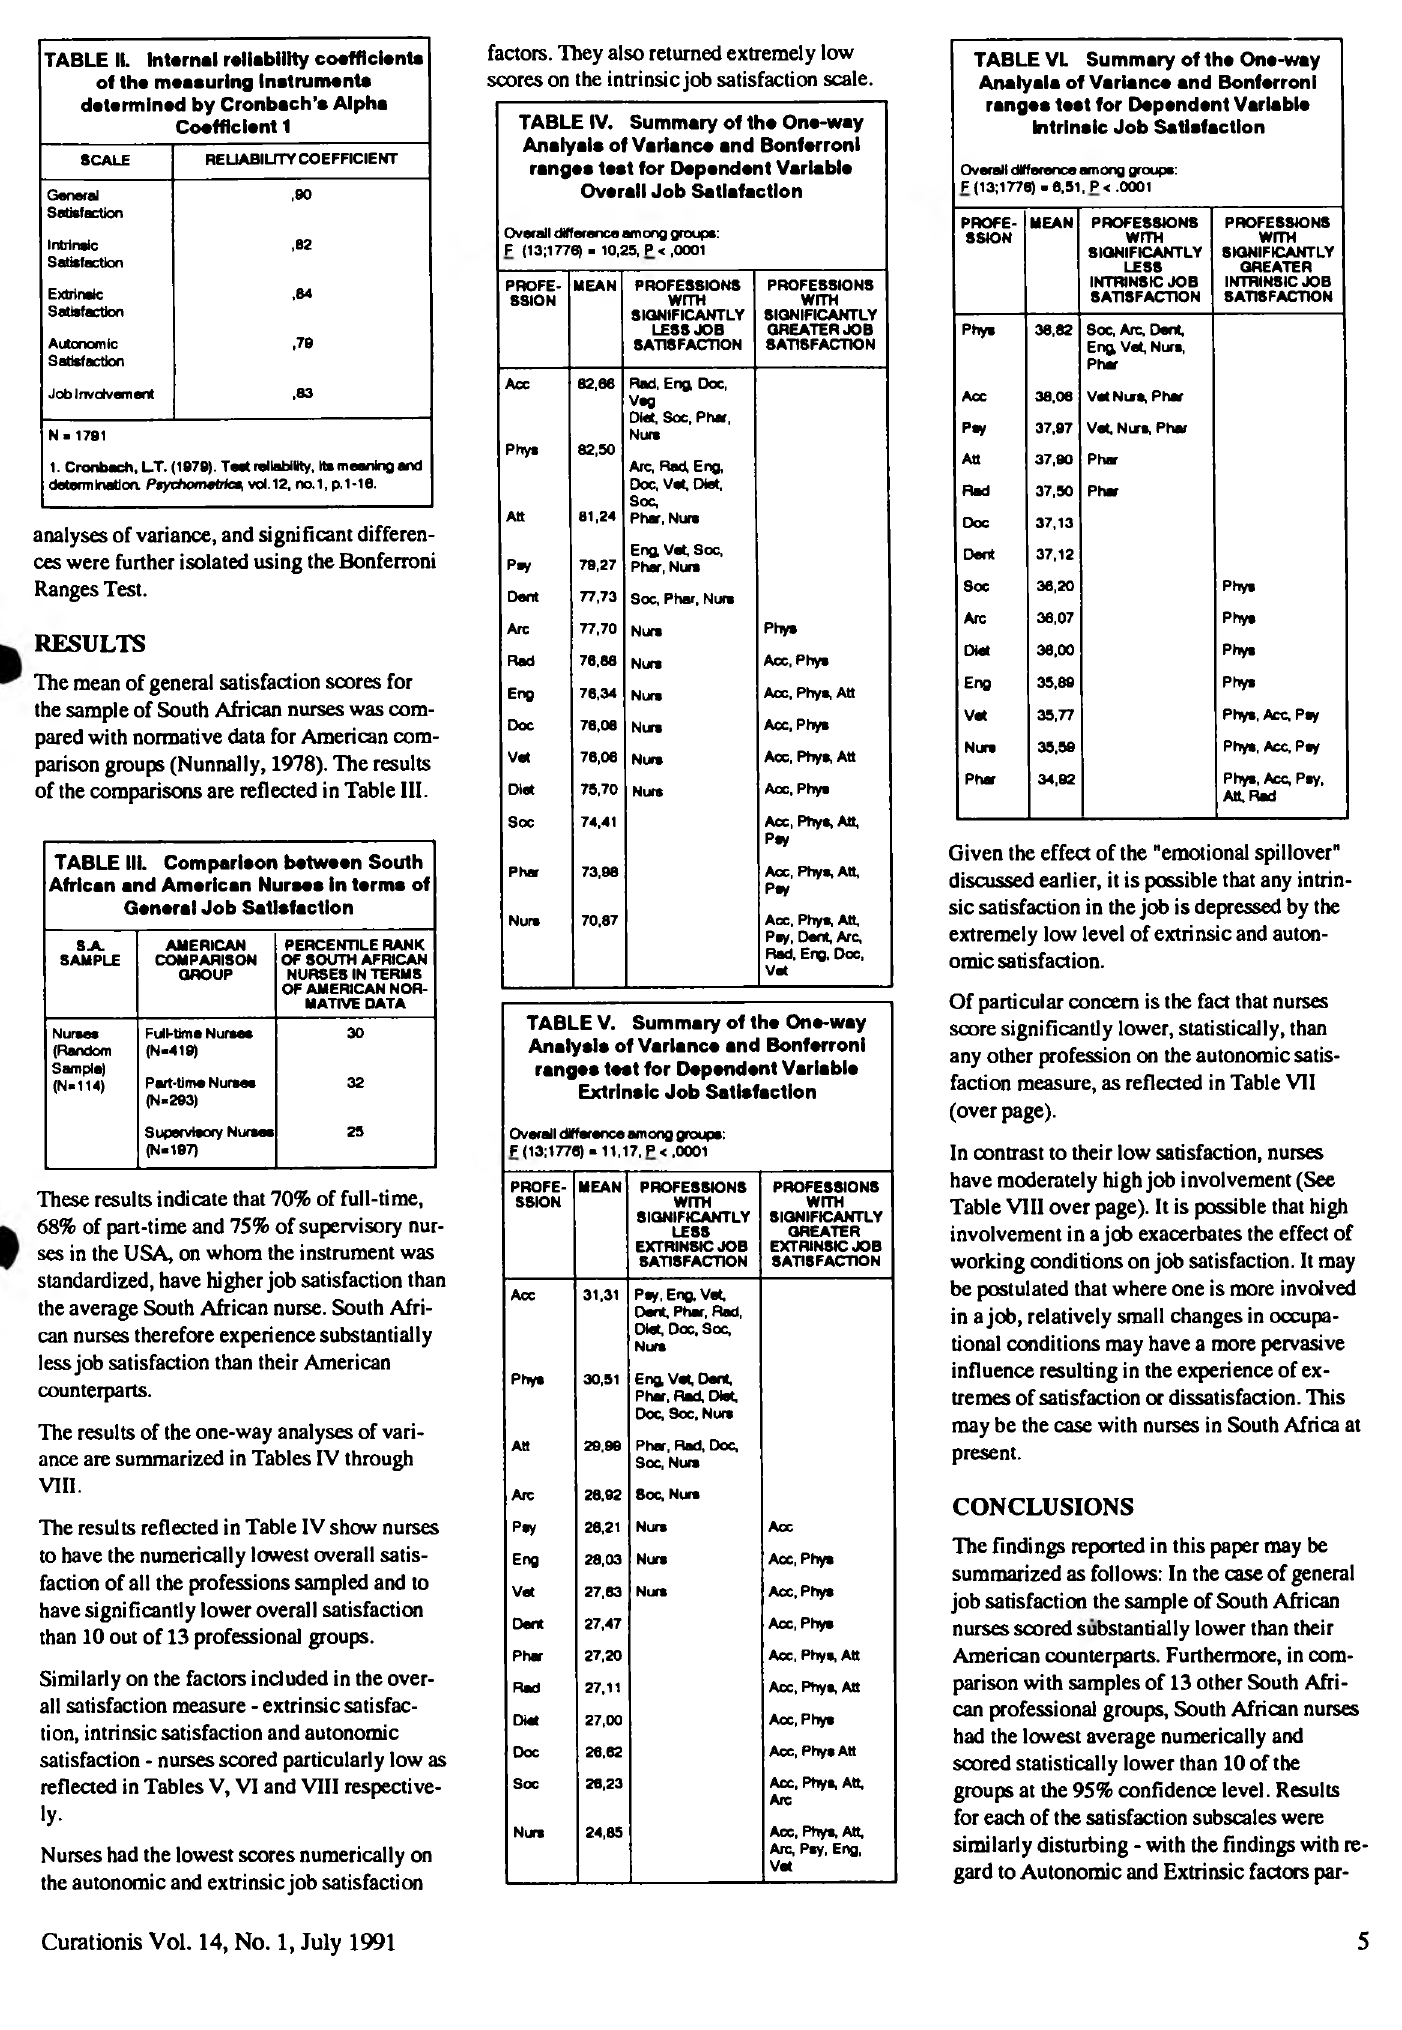
TABLE II. Internal reliability coefficient* of the measuring Instrument* determined by Cronbach’* Alpha Coefficient 1